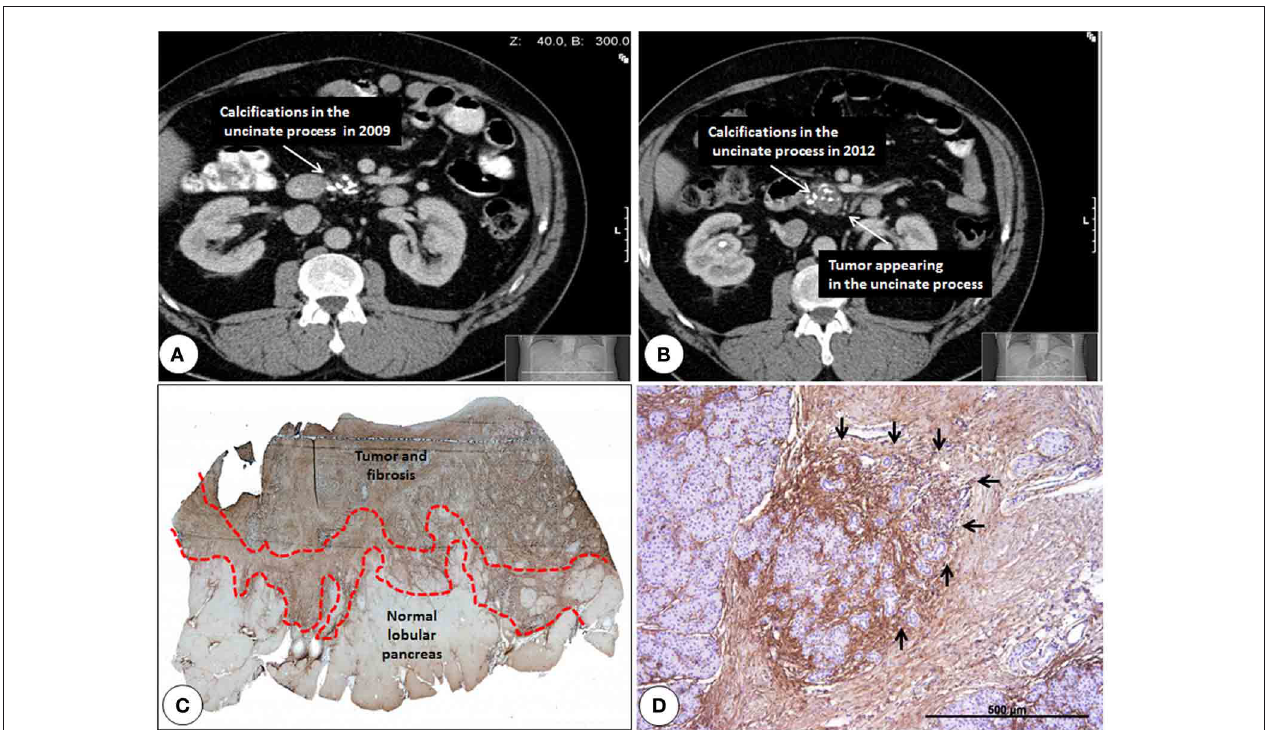
suggestive of cancer development. (C) Notice the finger-like extension of the activated stroma (marked by dotted lines) between the normal pancreatic lobuli and the cancer. Periostin staining (brown) is made without counterstaining. Original magnification 5x (D) strongest periostin expression is found around degenerating acini/atypical flat lesions (black arrows). Original magnification